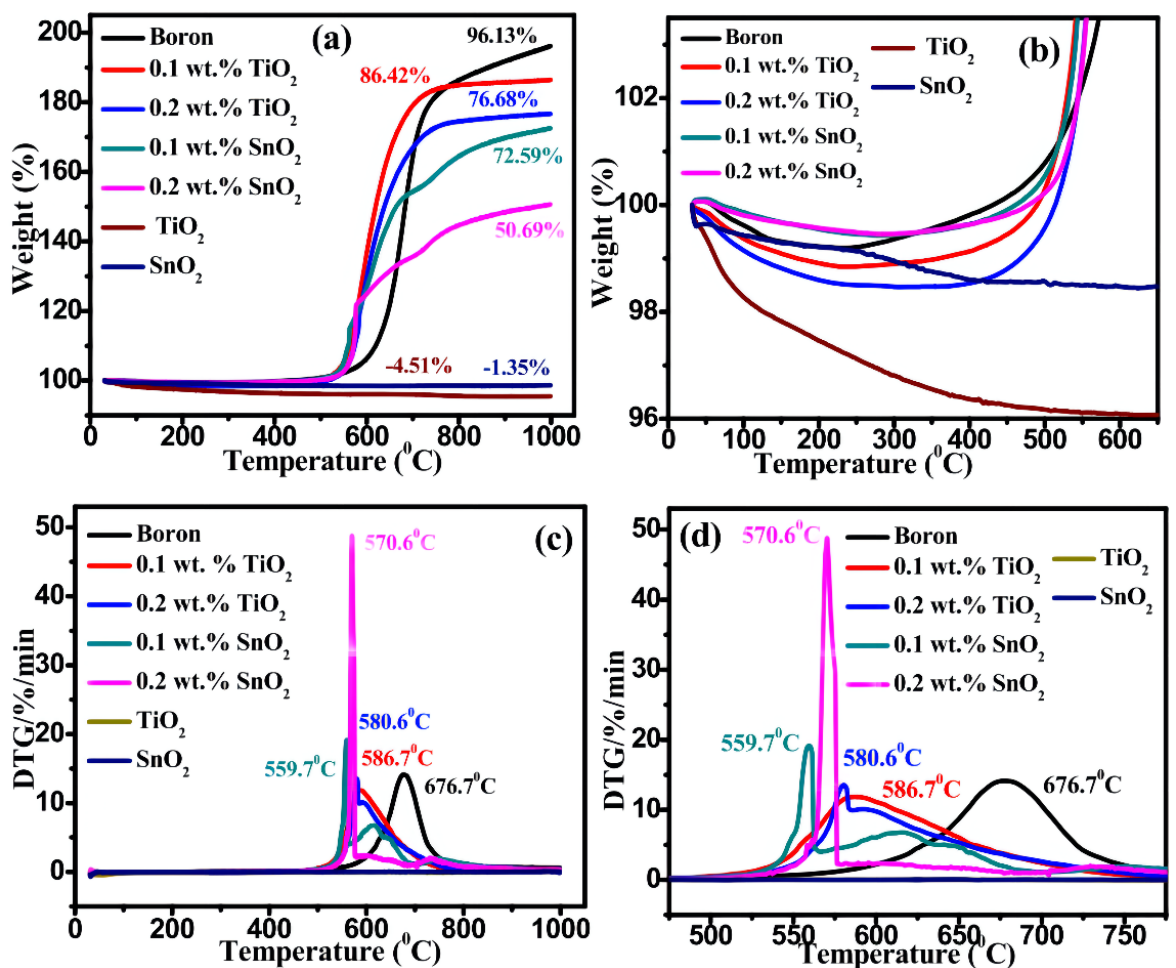
Figure 16. ( a ) TGA, ( b ) large view of TGA (25 – 675 °C), ( c ) DTG, and ( d ) large view of DTG (400 – 775 °C) of boron, TiO 2 , SnO 2 , and boron particles coated with 0.1 and 0.2 wt.% metal oxide (TiO 2 or SnO 2 ) in the presence of an air atmosphere [113].